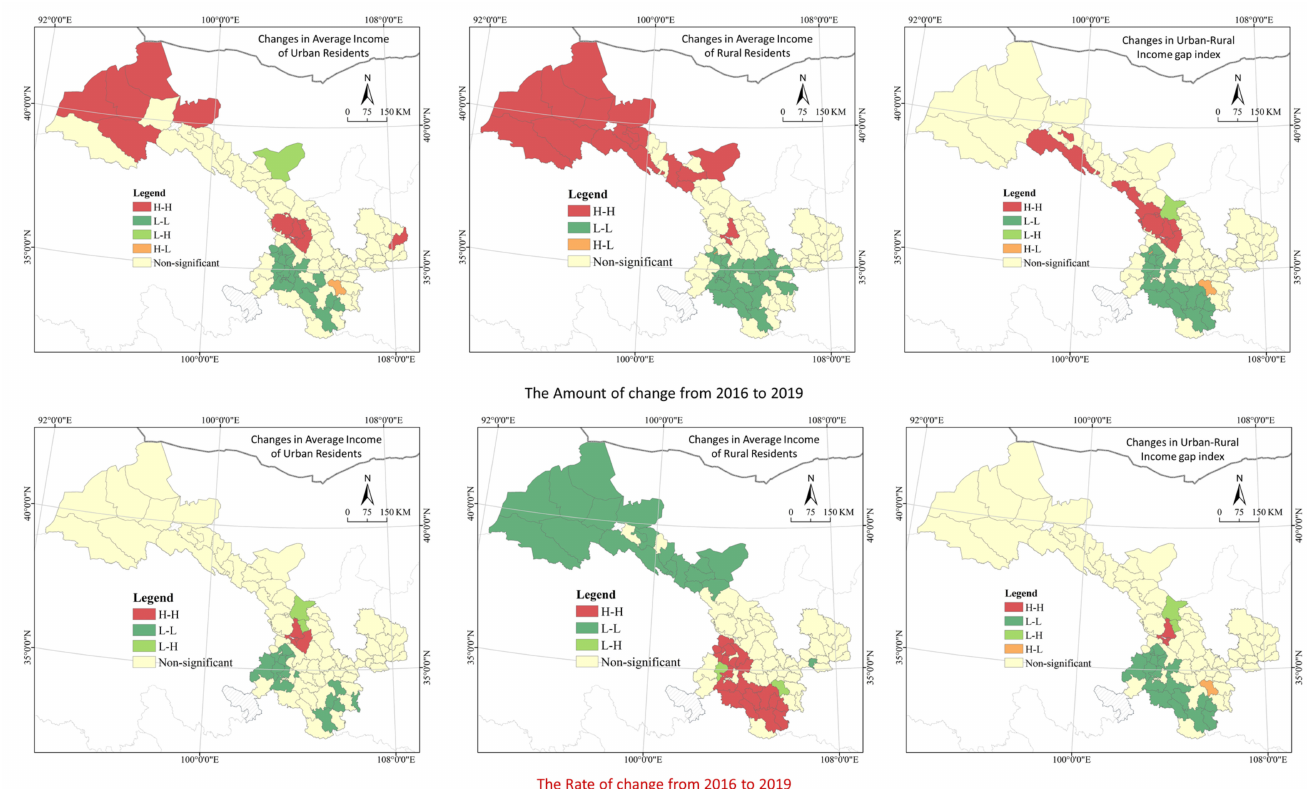
Figure 9. Analysis on Spatial correlation of